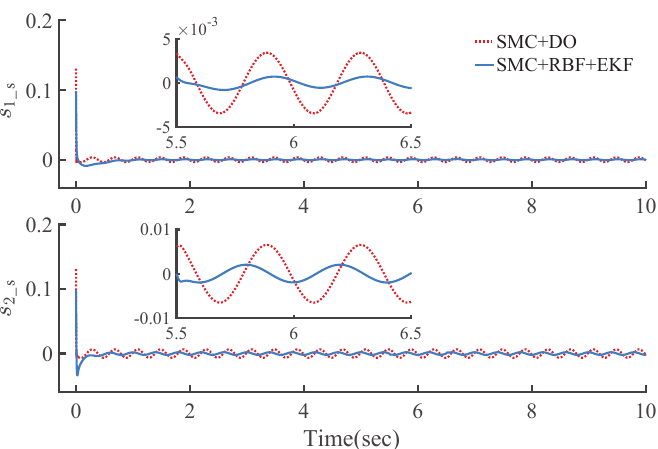
Figure 13. Time history of the slow sliding surface s _s .